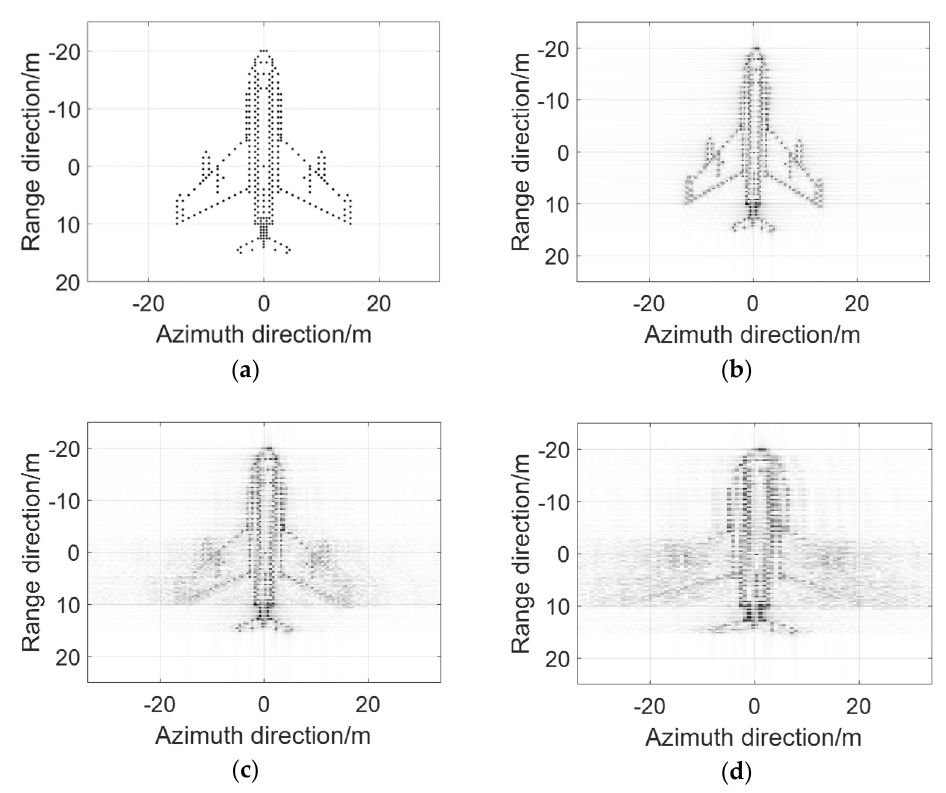
Figure 3. Imaging results of Yake-42 simulation model under different aperture extraction ratio: ( a ) Yake-42 simulation model; ( b ) Aperture extraction ratio 100%; ( c ) Aperture extraction ratio 75%; ( d ) Aperture extraction ratio 50%.